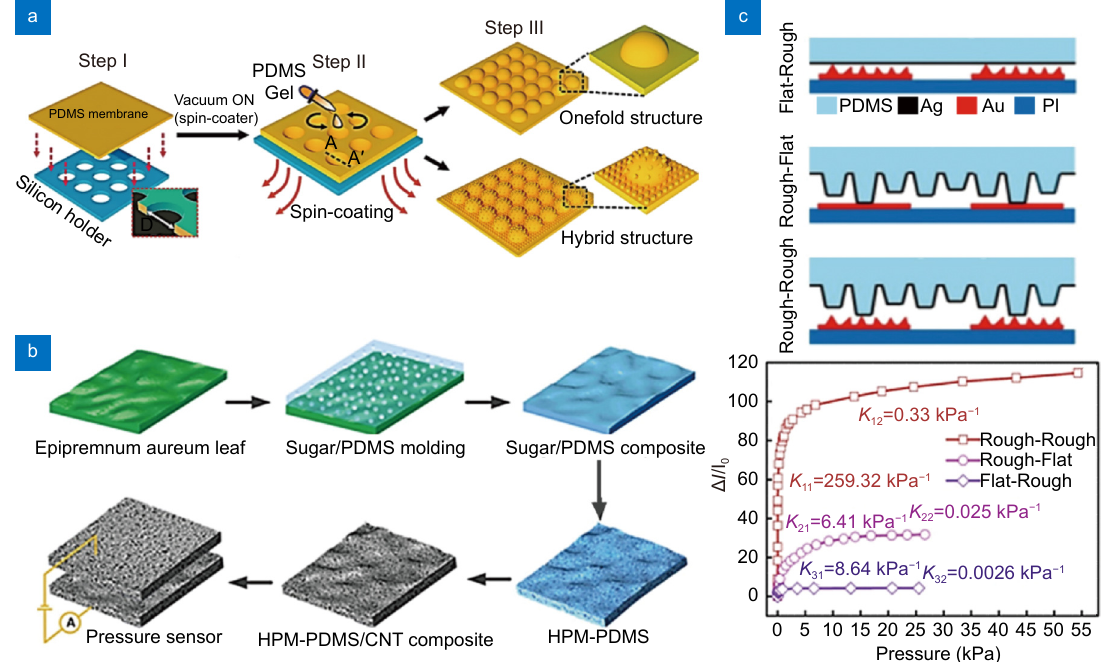
Fig. 6 | Piezoresistive design and manufacture with hierarchical structure. ( a ) Multiple dome structures as piezoresistance sensing layer 86 . ( b ) Multiple structure comprising of dense protuberances and porous structure as piezoresistance sensing layer 106 . HPM, hybrid porous micro- structure; and CNT, carbon nanotubes. ( c ) Piezoresistive sensitivities based on the sensing layers comprising of rough-to-rough, rough-to-flat and flat-to-rough surfaces 107 . Figure reproduced with permission from: (a) ref. 86 , (b) ref. 106 , (c) ref. 107 , American Chemical